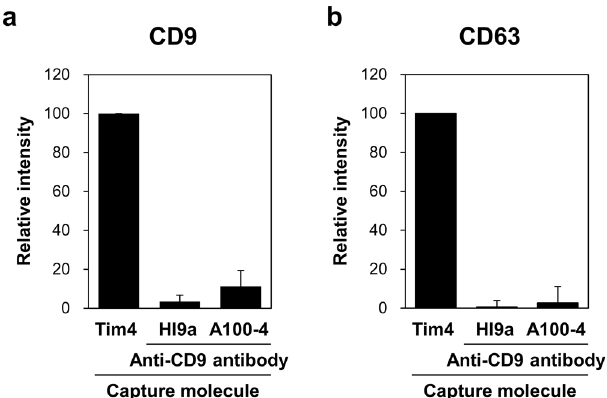
Figure 3. Comparison of the yield of purified EVs from serum between Tim4- and anti-CD9 antibody- based methods. Serum of normal donors (n = 6, 50 µL) was incubated with magnetic beads on which Tim4 or anti-CD9 antibody (HI9a or A100-4) was immobilized. After washing, bound EVs were released from Tim4 and anti-CD9 antibody by adding EDTA and glycine–HCl, respectively. Then, the purified EVs were subjected to bead-based sandwich ELISA for exosomal surface markers CD9 ( a ) and CD63 ( b ). The signal intensity is expressed as a ratio to that obtained with Tim4. Data are shown by mean ± SD.